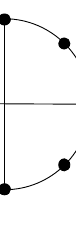
Figure 3. Constellation diagram for ( a ) h = 2/5 ( b ) h = 1/4.